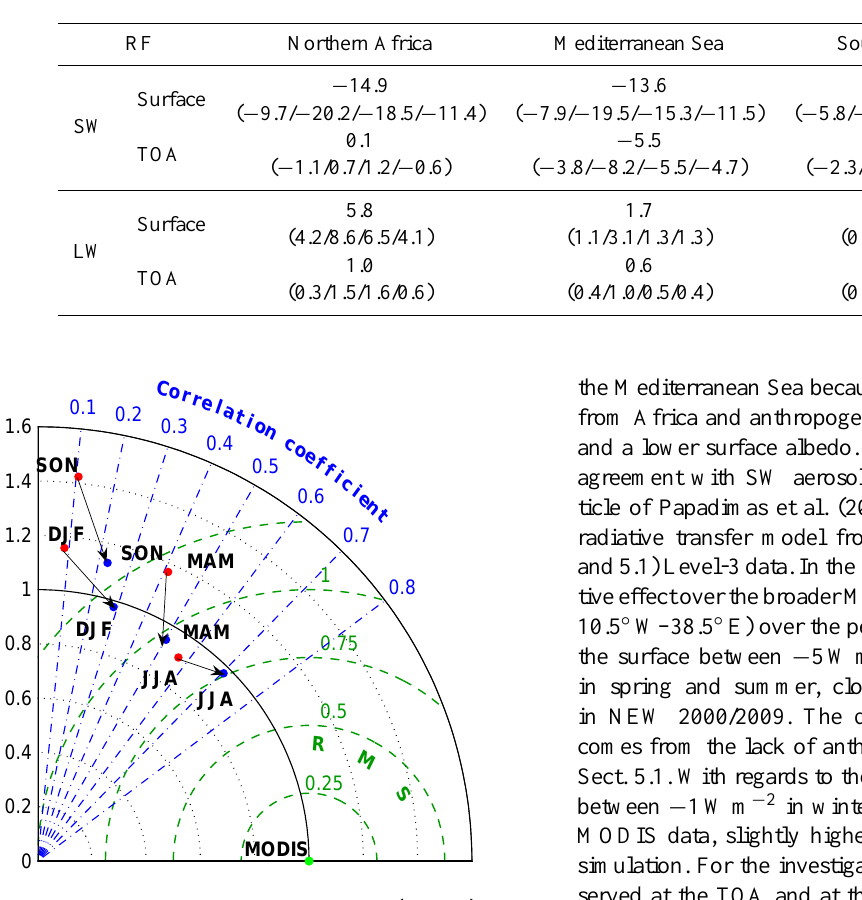
Fig. 12. Taylor diagram of seasonal averaged AOD (550nm) com- puted with MODIS observation, REF and NEW experiments. Red points: REF, blue points: NEW, green point: MODIS.